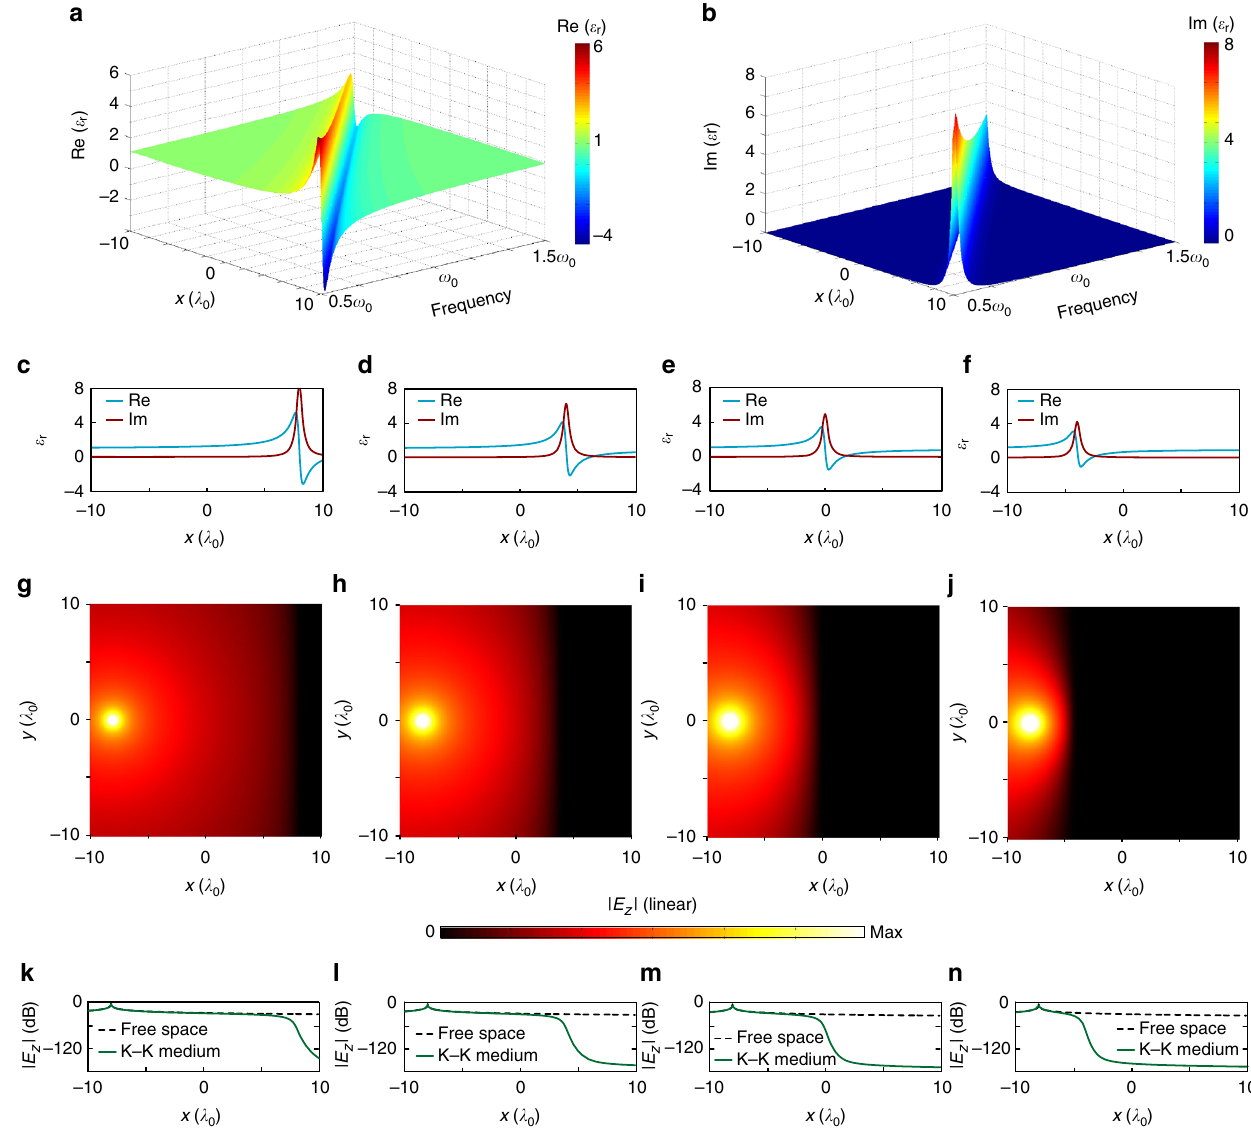
Fig. 1 Wave propagation in an inhomogeneous, dispersive medium. The permittivity pro fi le ε ( ω , x ) of this medium obeys the Kramers – Kronig (K – K) relations in both the frequency domain and the space domain, and its real ( a ) and imaginary ( b ) parts are given by Eq. (2) with parameters ω p = 0.4 ω 0 , γ = 0.03 ω = 0.5 ω – f Plots of the x- dependent complex permittivity at different frequencies (0.6 ω 0 , and q 0 . c g – j Simulated z -polarized electric fi eld radiated by a line source placed at x = − 8 λ 0 . Note that the same absolute color scale is used for all fi gures. While no re fl ection (standing wave) is seen, the waves are eventually dissipated in different resonance regions of the spatial K – K pro fi les for different frequencies. k – n The intensity drops in dB scale along the x axis for y =